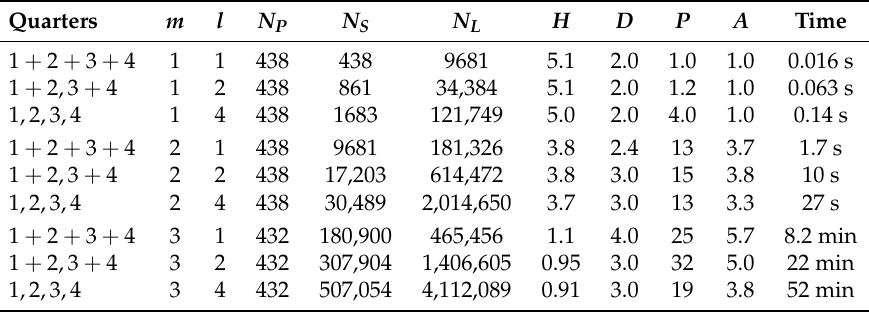
Table 1. Mapping higher-order network flows from air traffic data. Sparse memory networks corresponding to Markov order m = 1, 2, and 3 in one layer with data from quarters 1 + 2 + 3 +